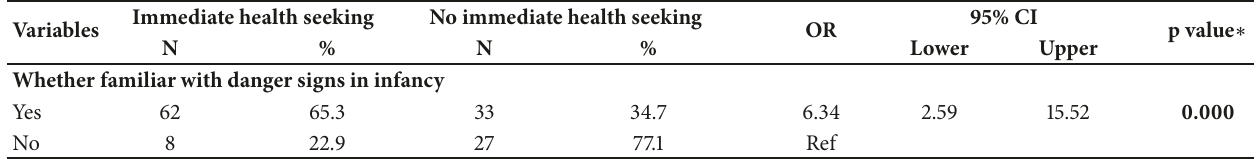
Table 4: Relationship between knowledge on danger signs and health seeking